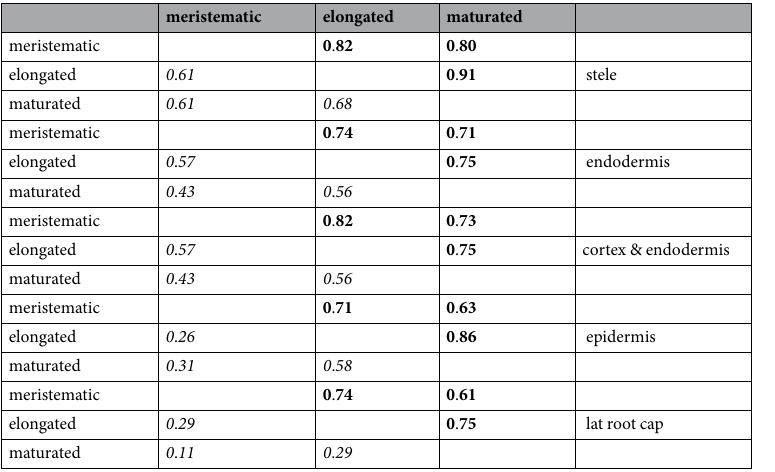
Table 4. Comparison of the predicted and the sampled flux distributions for the Birnbaum scenario. For the extracted models flux values were randomly sampled for each model. The comparison of the models is conducted only based on the reactions shared between the models in each of the groups of coupled and decoupled to facilitate unbiased comparison of specificity. The comparison is based on the R v -coefficient which ranges between 0 and 1. Similar to the Pearson correlation an R v -coefficient of 1 means high similarity. Bold font indicates values corresponding to the decoupled models, whereas the italic font corresponds to the coupled models.